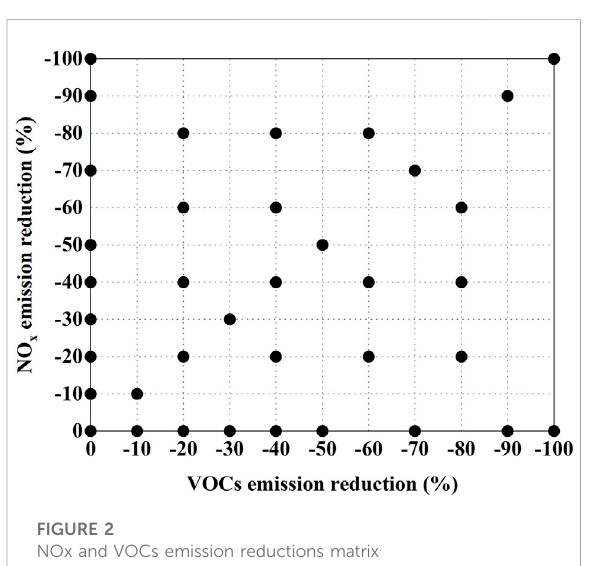
FIGURE 2 NOx and VOCs emission reductions matrix